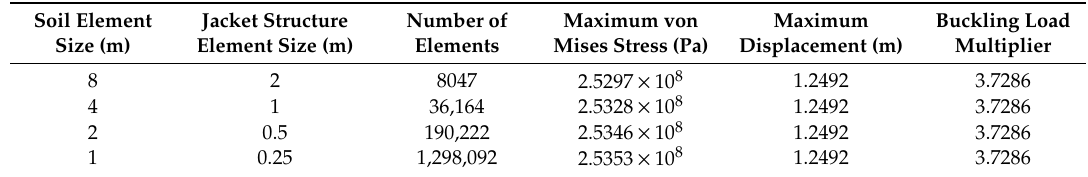
Table 4. Mesh sensitivity.